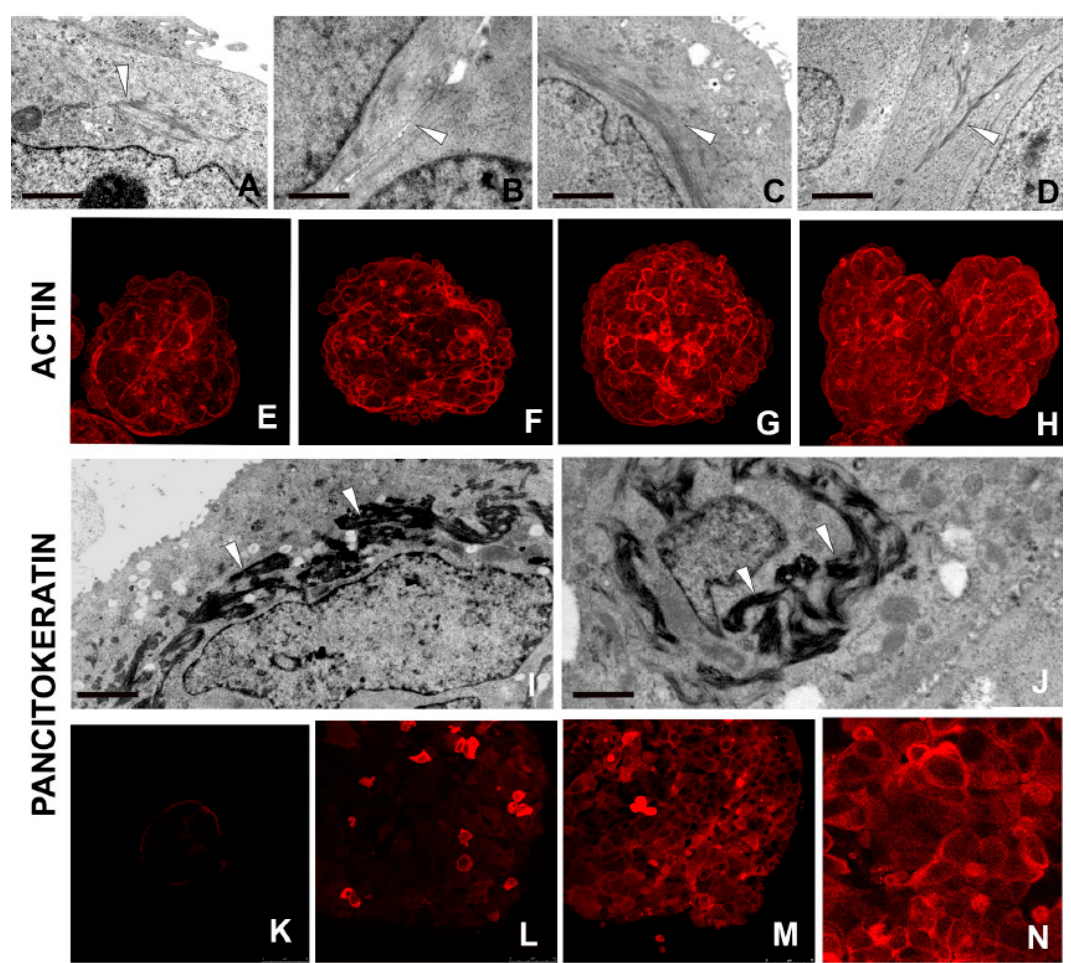
Figure 7. Morpho ‐ functional characterization of cells in developed spheroids. ( A – H ) TEM and immunocytochemical analysis. In well ‐ developed spheroids, the MCF7 cells show differentiation markers such as actin filaments forming bundles located close to the membrane or surrounding the nucleus ( A – D ) (arrowheads). Immunofluorescence staining ( E – H ) validate the morphological analysis by showing the highly expressed actin protein (red signal) in well ‐ developed spheroids. Scale